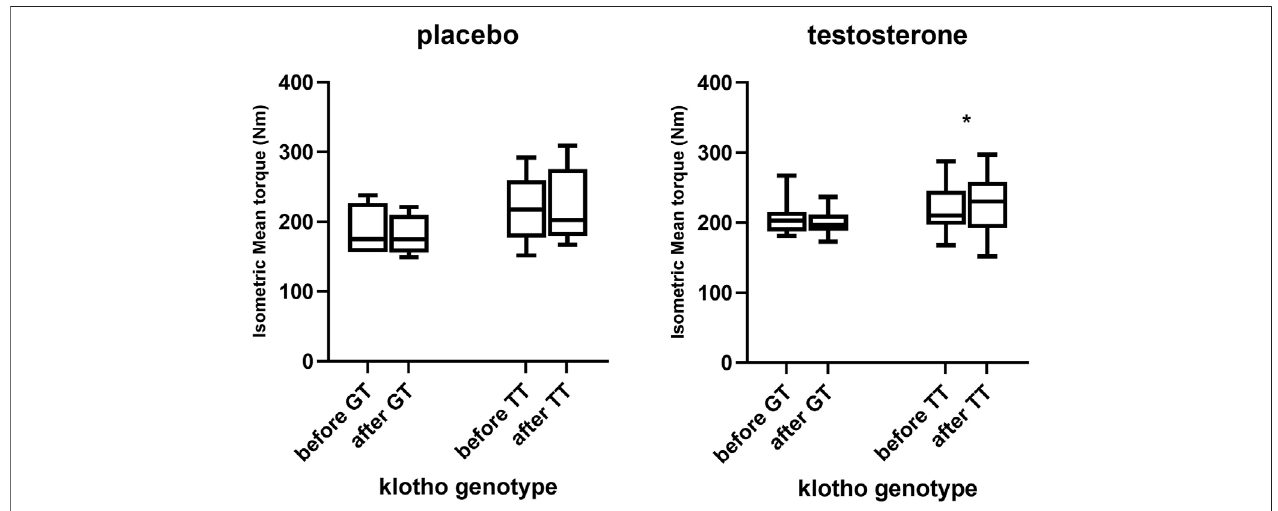
FIGURE 2 | Percentage change in knee extension mean torque and peak torque in different klotho genotype groups in participants treated with testosterone and placebo respectively ( n = 22 in each group). * p < 0.05.